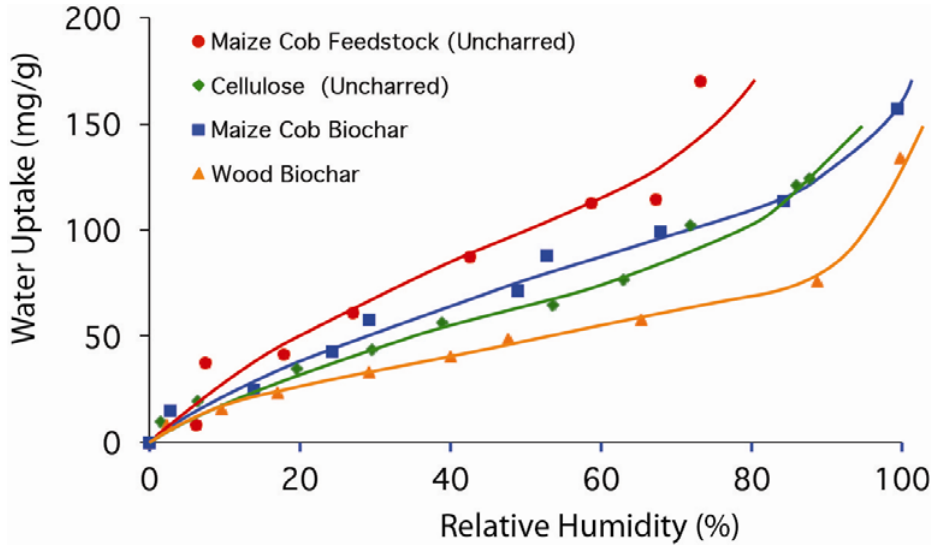
Figure 5. Water uptake of the two biochars used, wood biochar and maize cob biochar, as well as of the uncharred feedstock (maize cobs) and the main constituent of the uncharred feedstock,